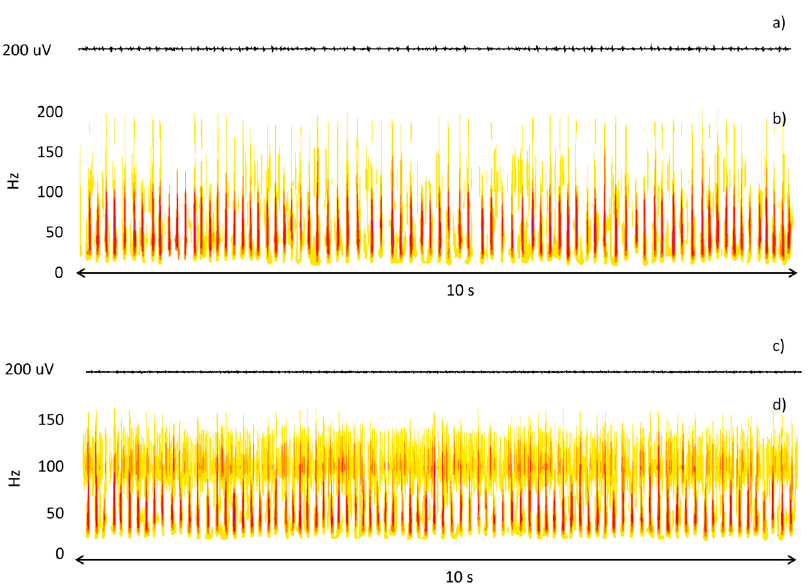
Figure 3. Time ( a , c ) and time-frequency ( b , d ) representation of two epochs subject to double check due to a disagreement between the expert assessors. In the first case, the time-frequency analysis highlights the presence of MUAPs; in the second case, it highlights the presence of EMIs.